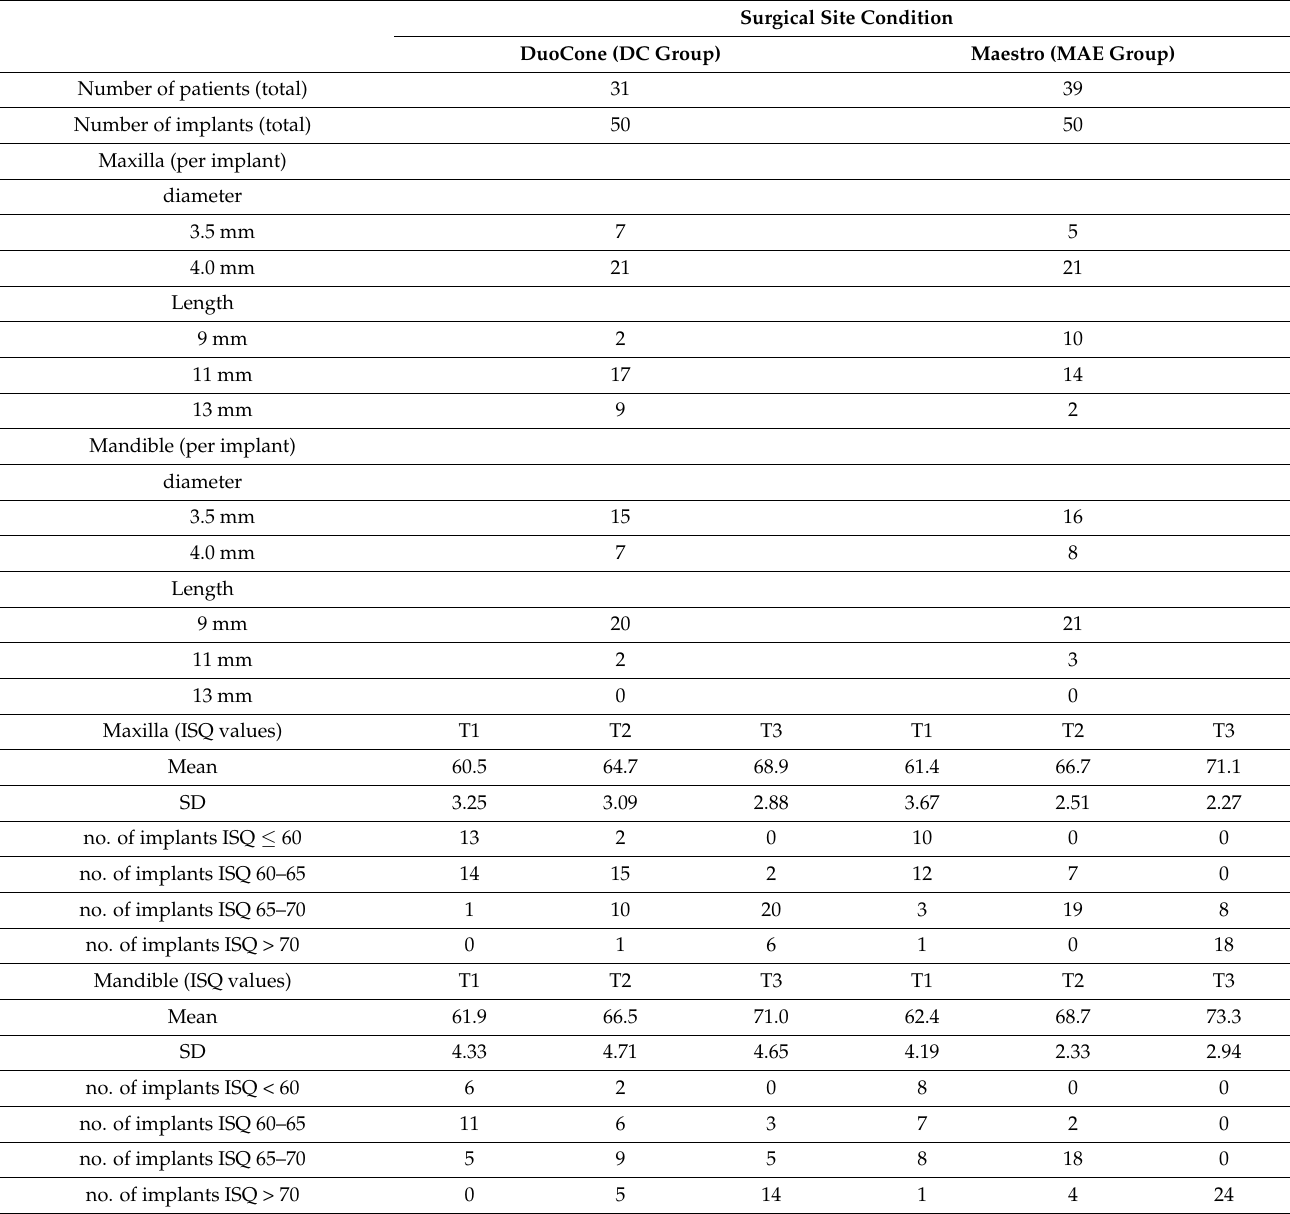
Table 1. Demographic